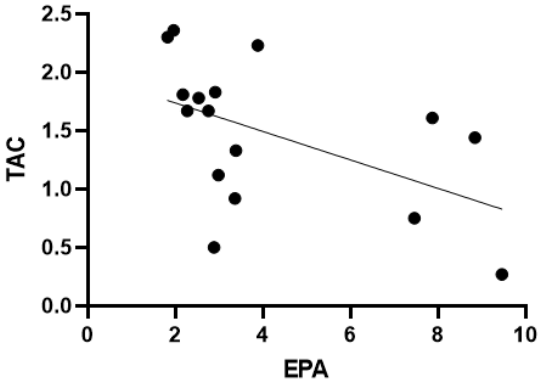
Figure 2. Correlation of TAC and EPA in AN patients. AN = anorexia nervosa, TAC = total antioxidant capacity, EPA = endogenous peroxidase